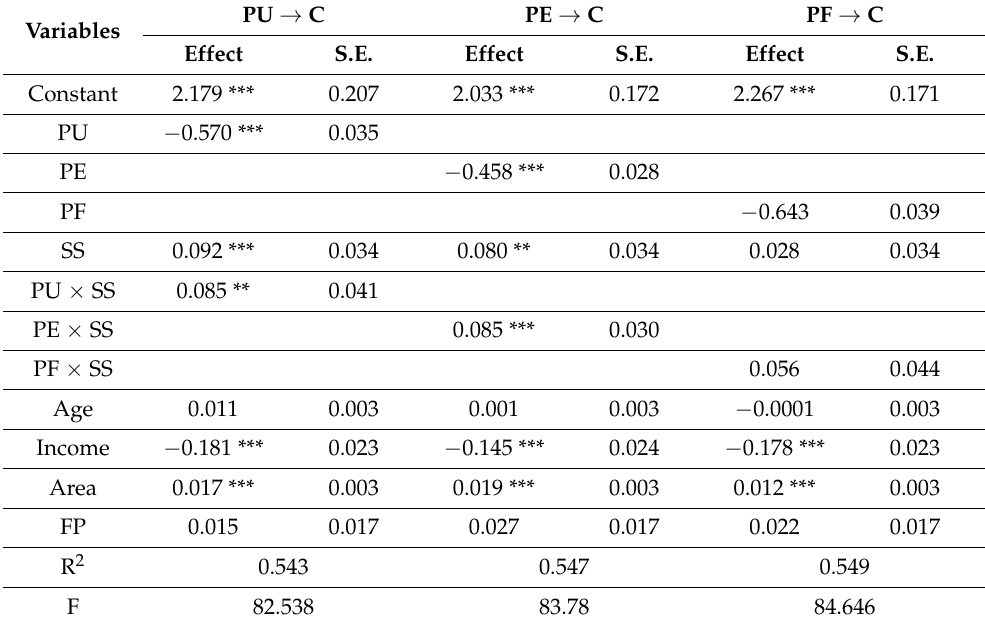
Table 8. The moderating effect of social